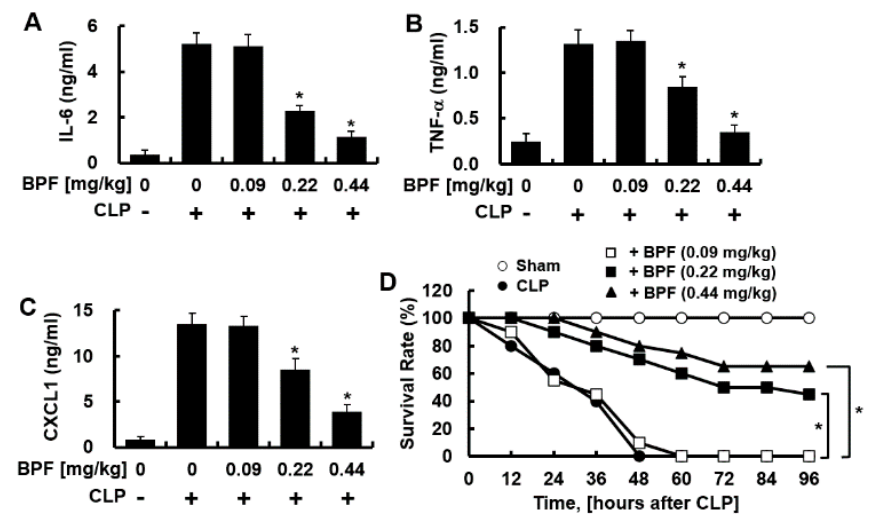
Figure 6. BPF suppresses CLP-induced cytokine production of peritoneal macrophages and improves the mortality of CLP mice. ( A – C ) CLP-operated mice were injected with DMSO or BPF (0.09, 0.22, or 0.44 mg/kg, intravenous injection). After 12 h, the mice were euthanized. Peritoneal macrophages were collected from CLP-operated mice and the levels of the indicated inflammatory cytokines were determined using ELISA (n = 5). All results are shown as means ± SD of three different experiments with triple samples. * p < 0.1 compared to CLP only; ( D ) CLP surgery was conducted on mice and the indicated reagents were administered every 24 h (n = 20). The survival of mice was monitored for 96 h. * p < 0.5.